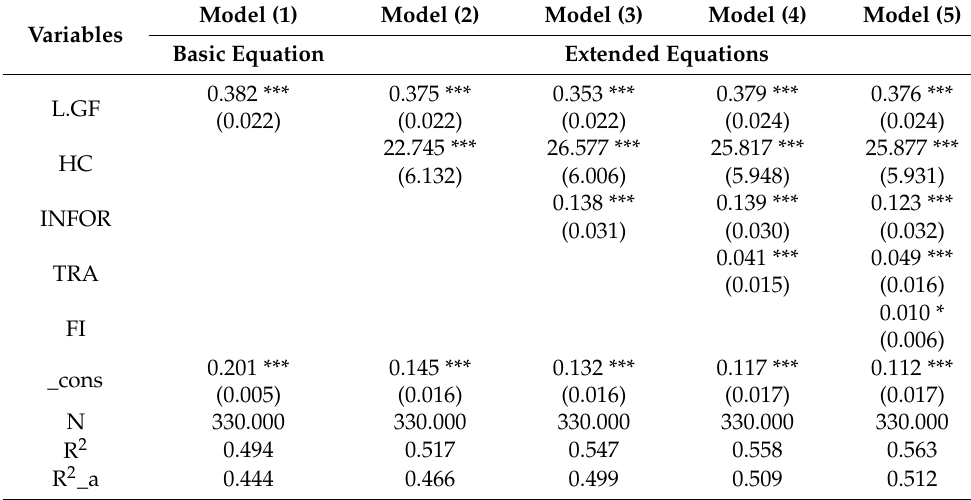
Table 10. Lagged effects of green finance.